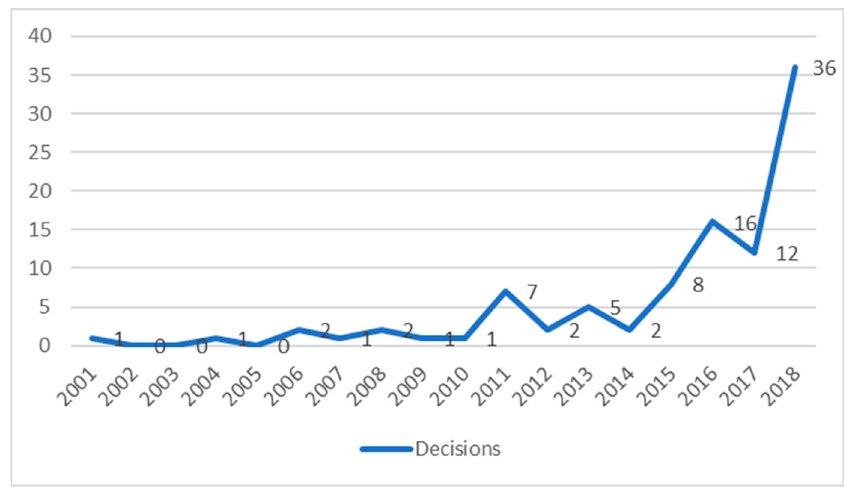
Figure 10. Number of decisions mentioning a right to water over the years.